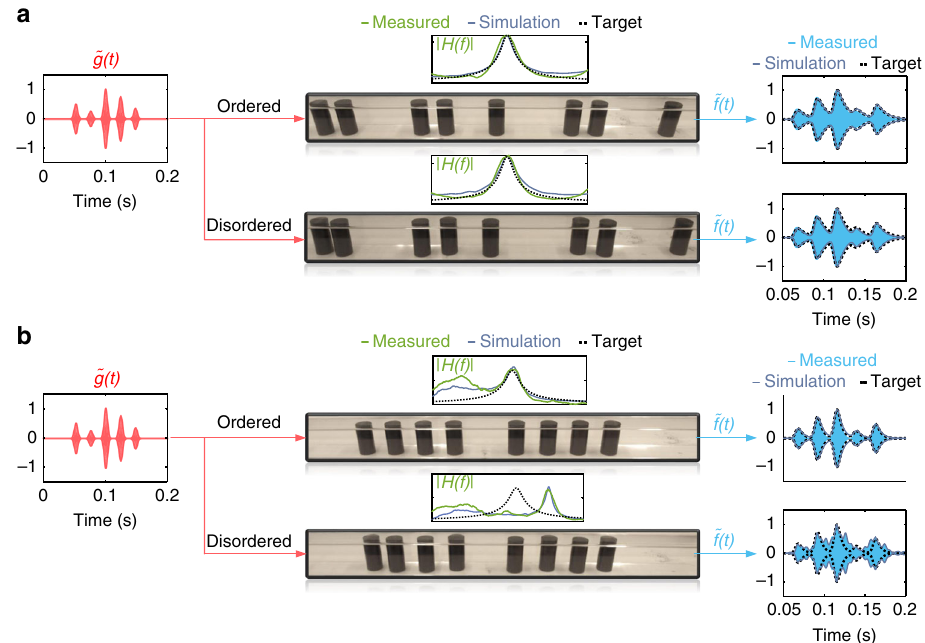
Fig. 4 Experimental demonstration of the topological equation solver. The acoustic waveguide is a square transparent tube and the scatterers are made from black Nylon rods. As in our numerical investigations of Fig. 2, we compare the trivial signal processors in terms of robustness to position defects. A frequency domain measurement allows us to extract the transfer function H ( f ) (green line), which we compare to the ideal target (dashed line) and simulation (gray). An additional measurement then performed in time domain by directly sending an input signal with envelope g ( t ) into the system, and recording the coda with envelope f ( t ) at the output. a The topological equation solver is indeed found to be immune to the shits in rods position. b Very differently, the trivial equation solver is severely affected. The parameters of the linear differential equation are chosen to be α = 2.7 π , β = 10 π /3, and